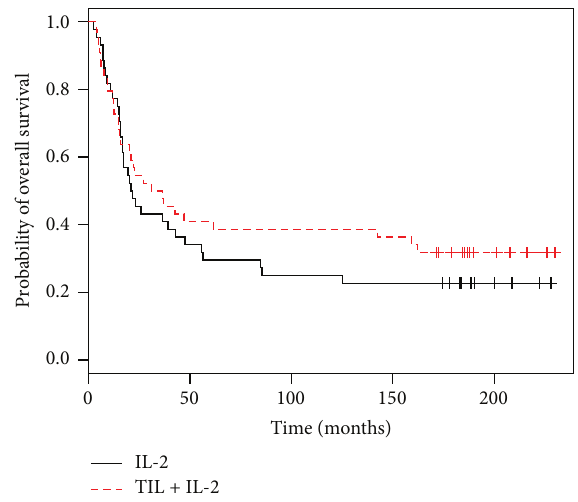
Table 1: Patient characteristics according to the treatment